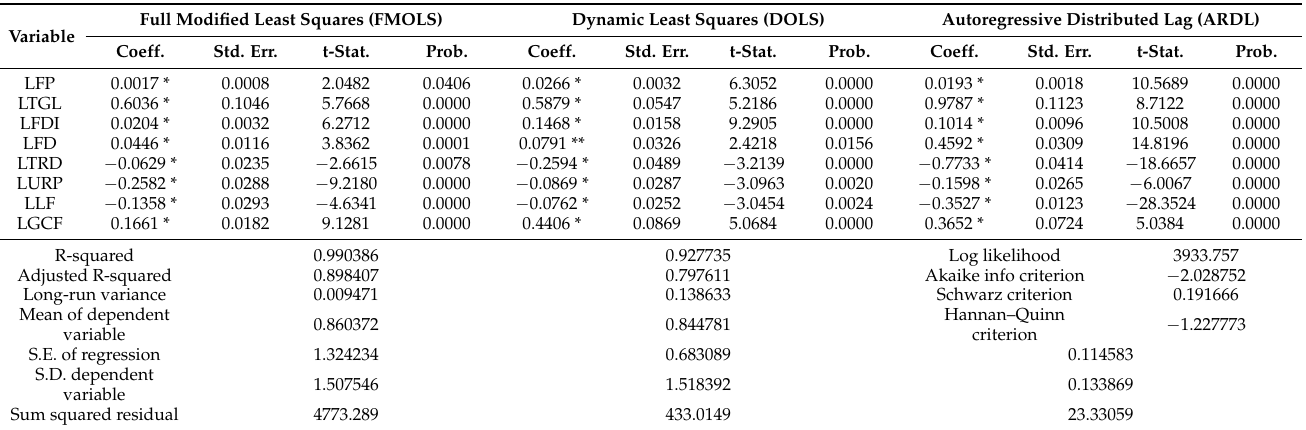
Table 7. Long-run elasticity estimates (FMOLS, DOLS, and